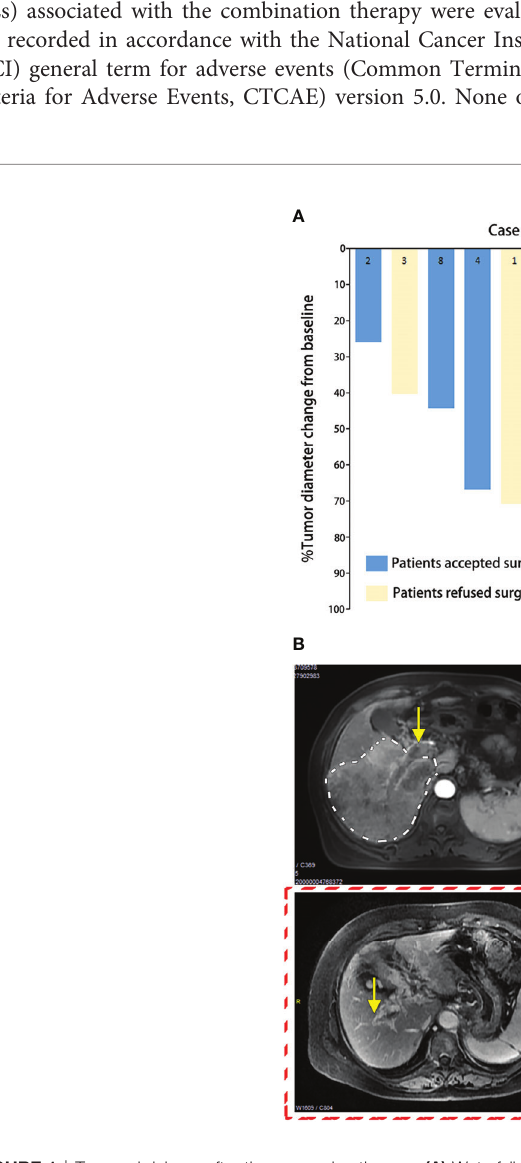
FIGURE 1 | Tumor shrinkage after the conversion therapy. (A) Waterfall plot of maximum tumor shrinkage based on the modi fi ed response evaluation criteria in solid tumors (mRECIST) per independent imaging review. (B) Radiologic change of case no. 1. Before treatment ( fi rst image outside the red dotted line ): tumor located in the right liver (outlined in white dotted line ) and portal vein tumor thrombus (PVTT) in the right portal vein ( yellow arrow ). After treatment (outlined in red dotted line ): tumor shrinkage (outlined in white dotted line ), future liver remnant (FLR) enlargement, cavernous transformation of portal vein, and recanalization of the intrahepatic portal vein ( yellow arrow